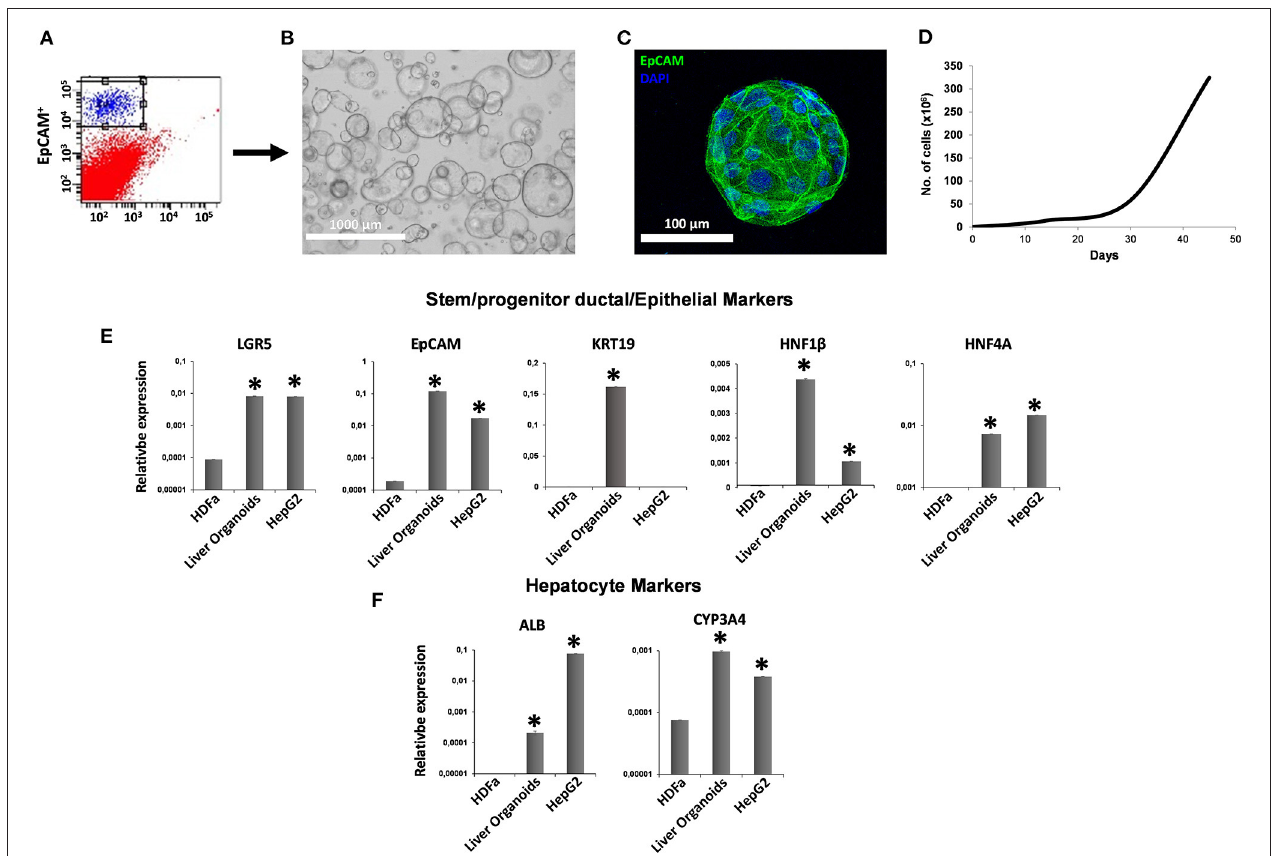
FIGURE 1 | Generation of liver organoids. (A) Human liver cell suspensions were analyzed by FACS analysis and separated into EpCAM + and EpCAM − cells. (B) Representative DIC image of organoid cultures. (C) Immunofluorescent confocal microscopy imaging of liver organoid showing epithelial cell adhesion molecule (EpCAM) (green). (D) Number of cells counted per well at each passage from P1 to P5. (E,F) Gene expression of stem/progenitor, ductal/epithelial markers, and hepatocyte markers. Transcript levels were normalized to those of GAPDH and expressed as relative expression (2 − 1 Ct ). Data are means ± SD. * p < 0.05 vs. HDFa. DIC, differential interference